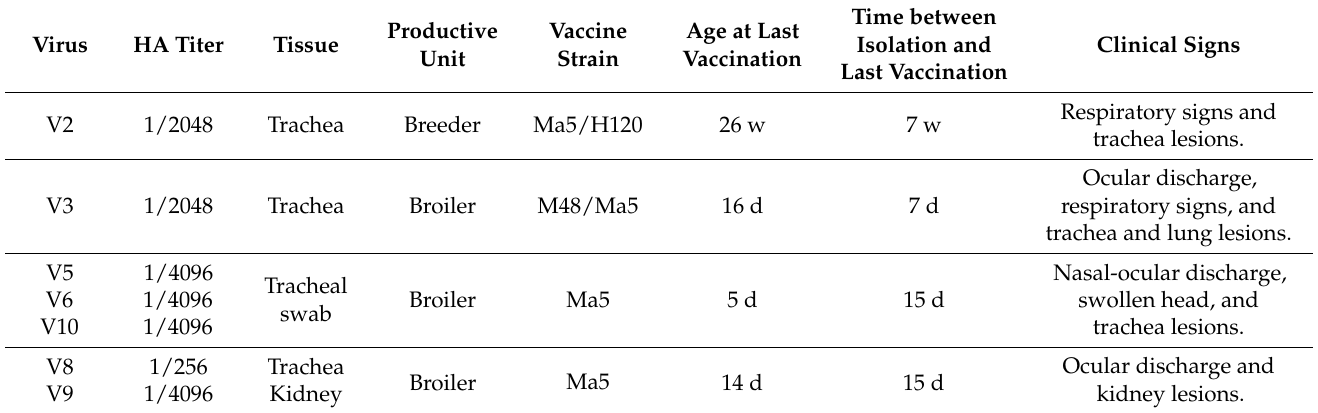
Table 1. Clinical history of poultry associated with Infectious Bronchitis Virus (IBV) isolates obtained between 2012 and